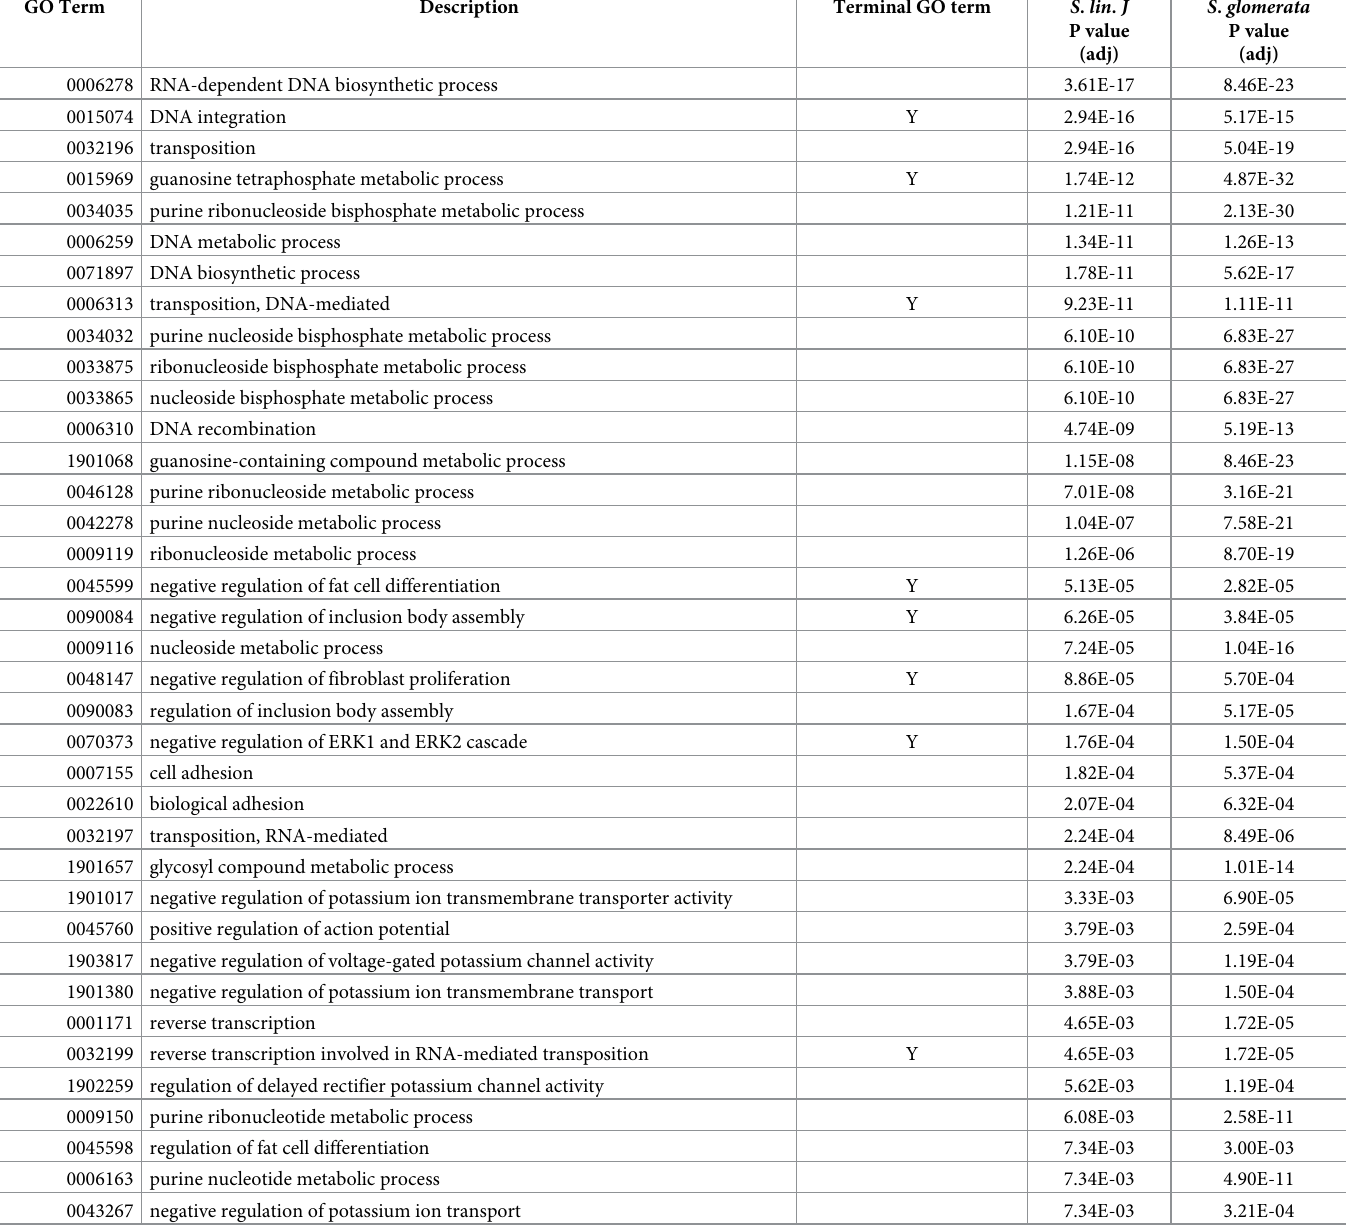
Table 3. GO categories enriched in Saccostrea -specific